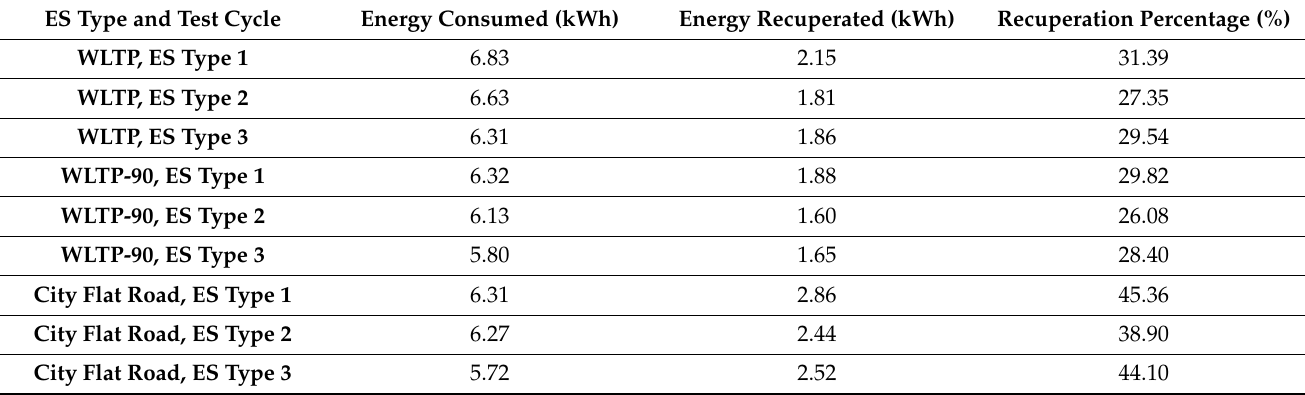
Table 7. Vehicle energy consumed and recuperated, at 0 ◦ C ambient temperature.